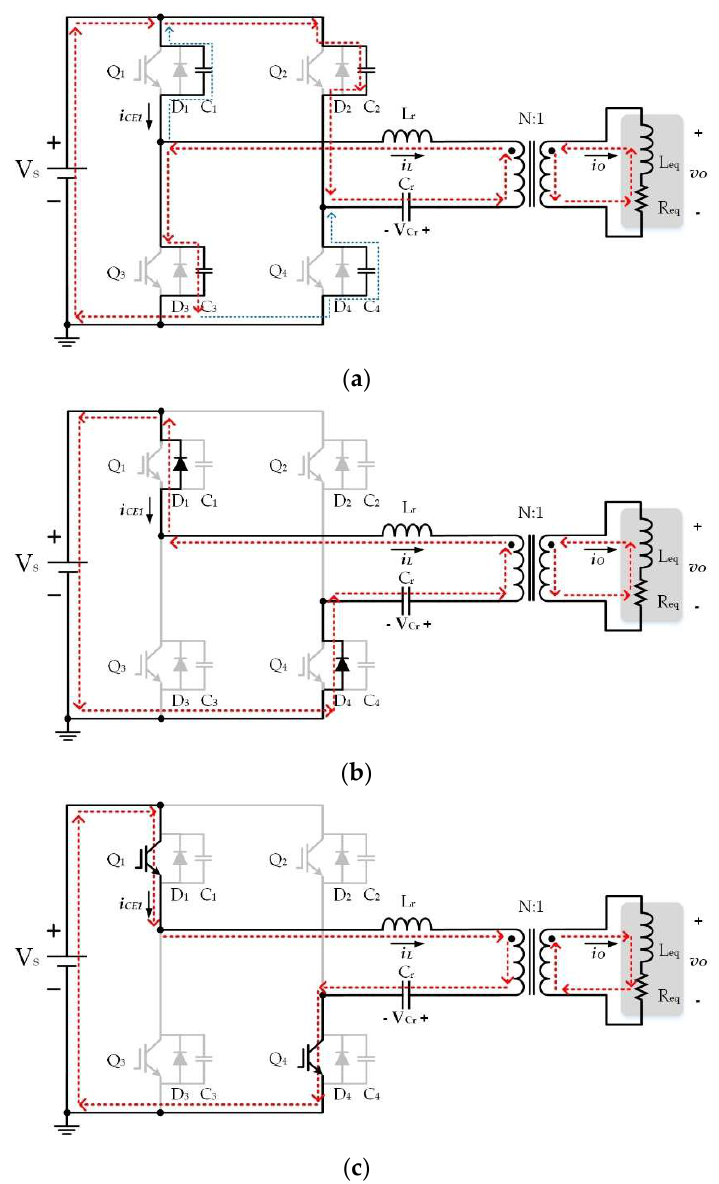
Figure 8. Operation modes of the full-bridge LC series resonant converter: ( a ) Interval I (t 0 −t 1 ), ( b ) Interval II (t 1 −t 2 ), and ( c ) Interval III (t 2 −t 3 ).